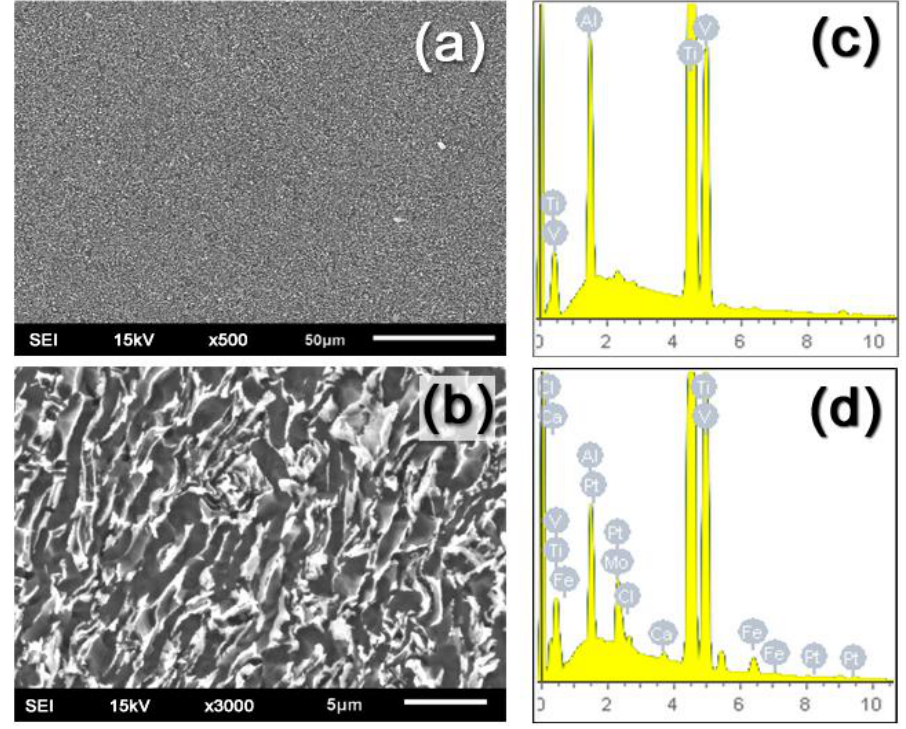
Figure 10. SEM/EDX for the as hot swaged Ti-54M sample after five days of immersion in 2 M HCl solutions, ( a ) and ( b ) are the SEM images; ( c ) and ( d ) are the EDX profiles for the area shown in ( a ) and ( b ),